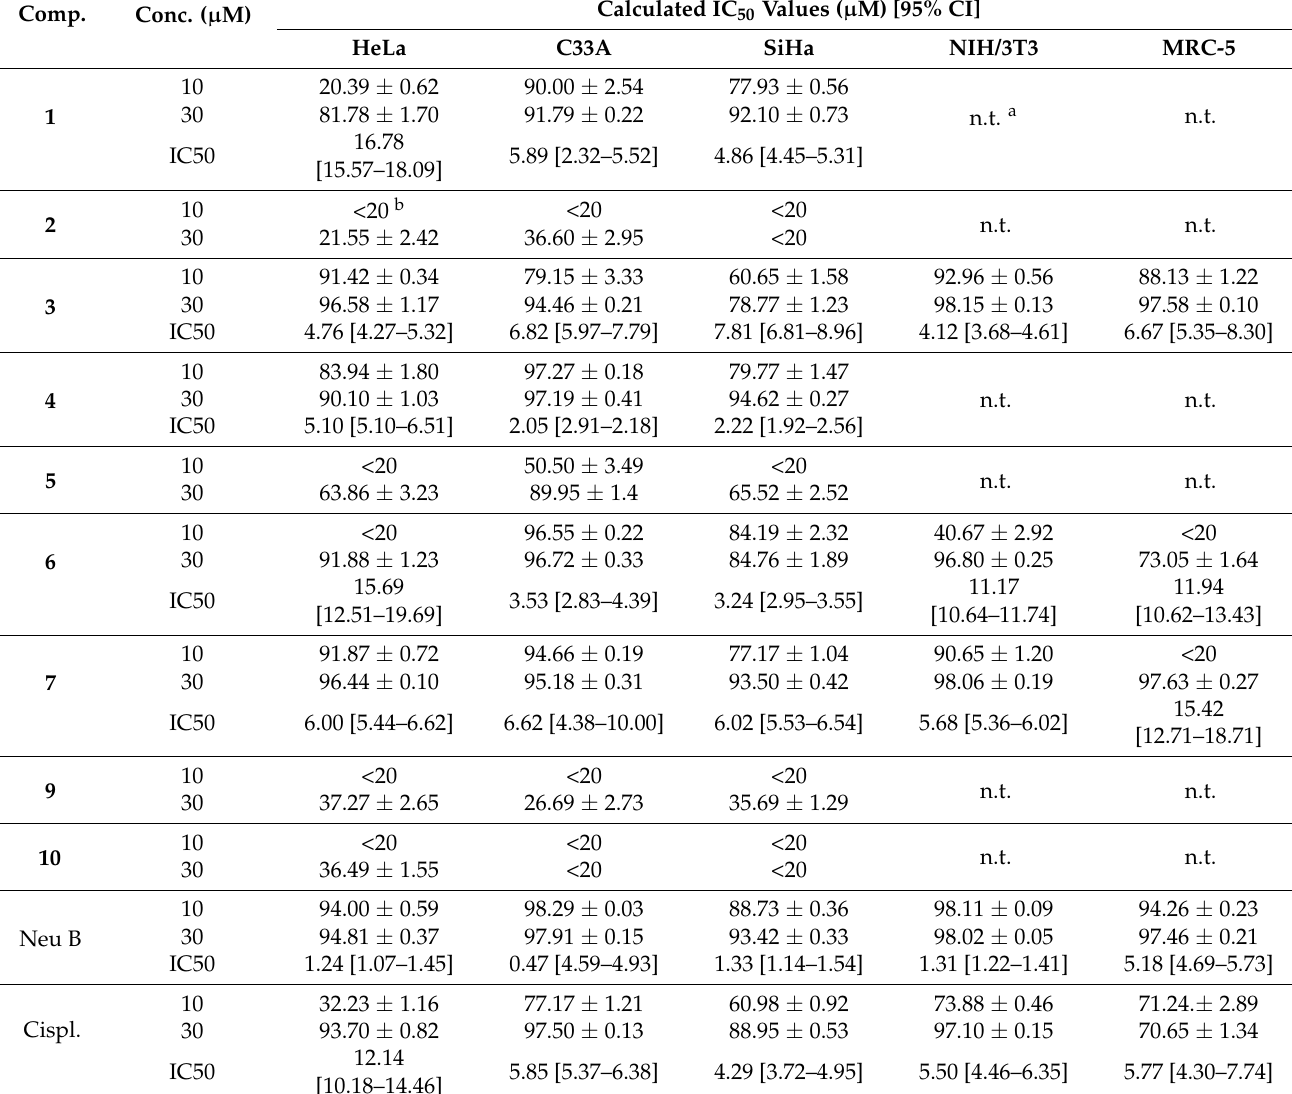
inhibitor of metalloproteinase 2 [55]. Table 4. Antiproliferative activity of the isolated compounds determined by MTT assay. Growth inhibition and calculated IC 50 values of the tested compounds and their 95% confidence intervals (CI).